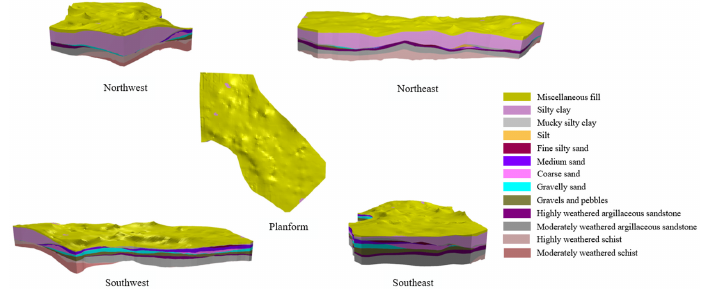
Figure 16. The final geological model of the old town in Xinyang City with five perspectives.